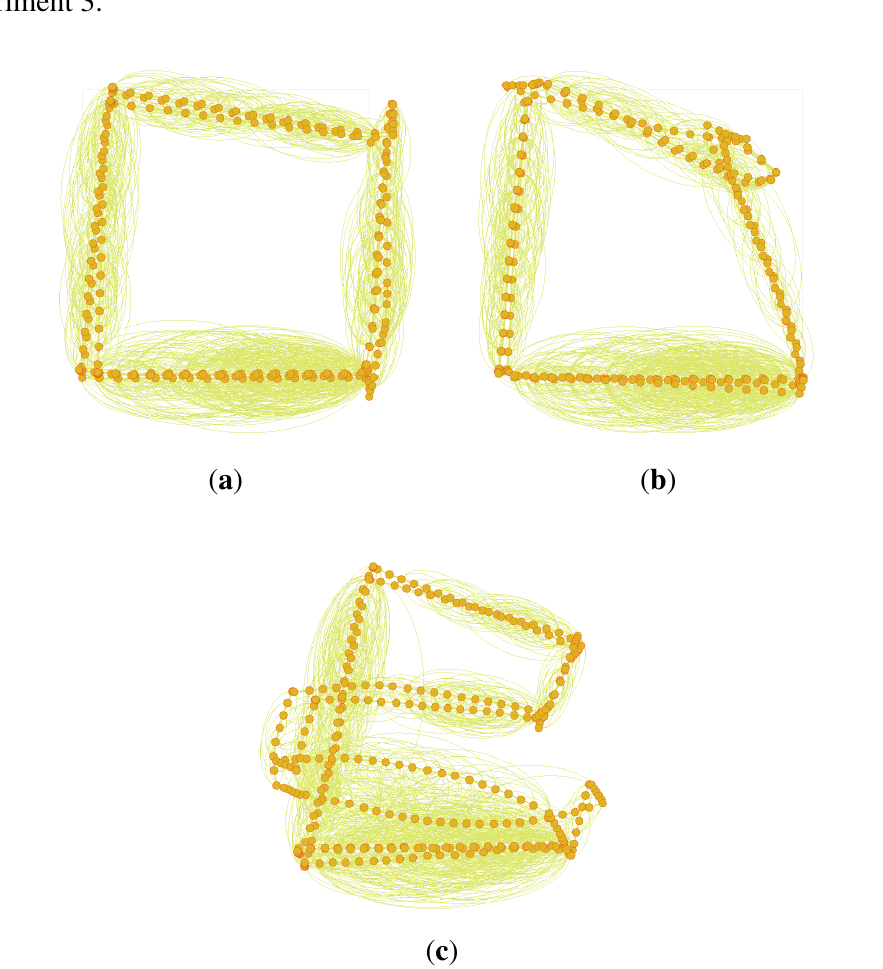
Figure 19. Graph structures obtained from the conventional graph SLAM. The trajectories were distorted due to the low dynamic